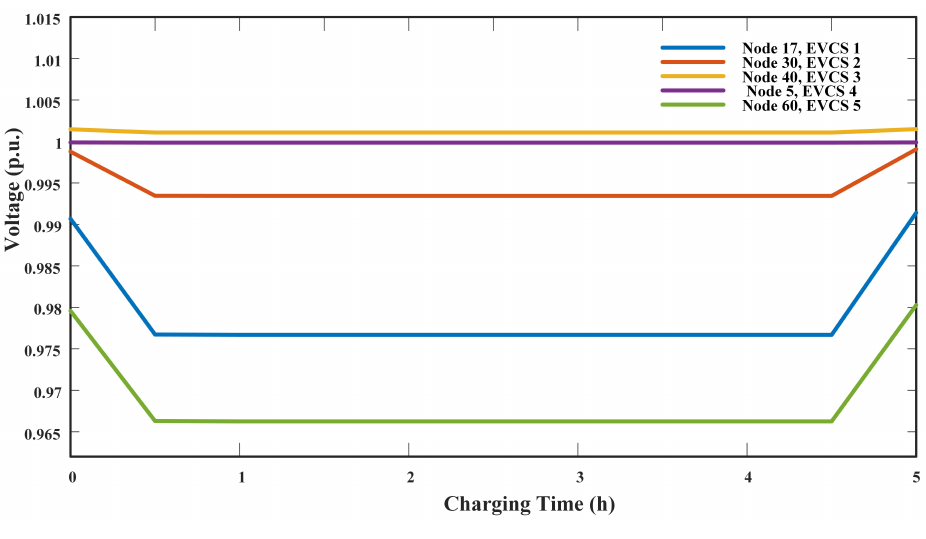
Figure 16. EVCS voltage